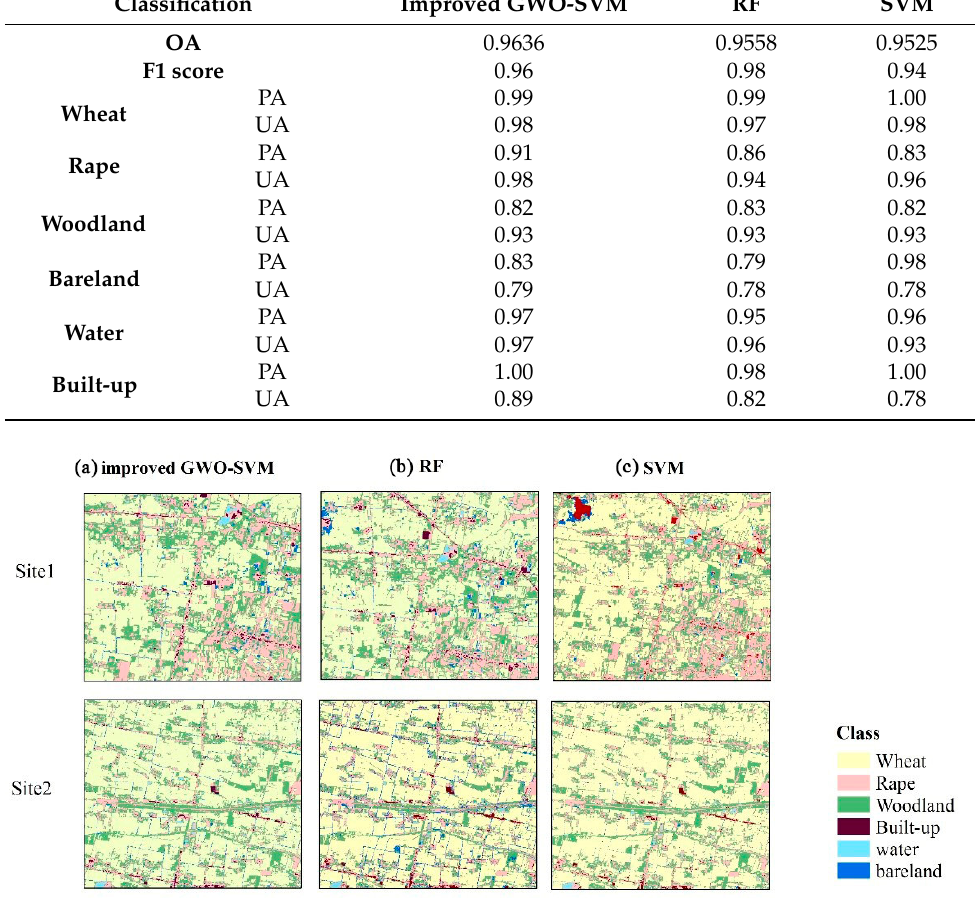
Figure 12. The crop mapping results and overlay analysis based on different methods. Site 1 and site2 are selected from Huaibin County. ( a ) Comparison of improved GWO-SVM mapping results, ( b ) comparison of RF mapping results, ( c ) comparison of SVM mapping results. Table 6. The classification accuracy for improved GWO-SVM, RF and SVM.